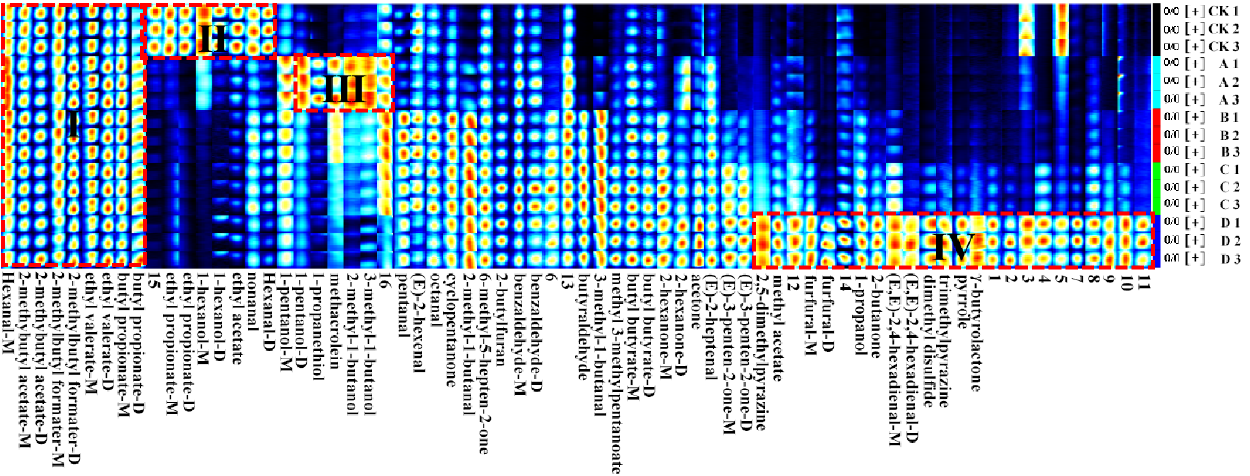
Figure 2. Fingerprints of volatile compounds in pomegranate seeds at different processing temper- atures.